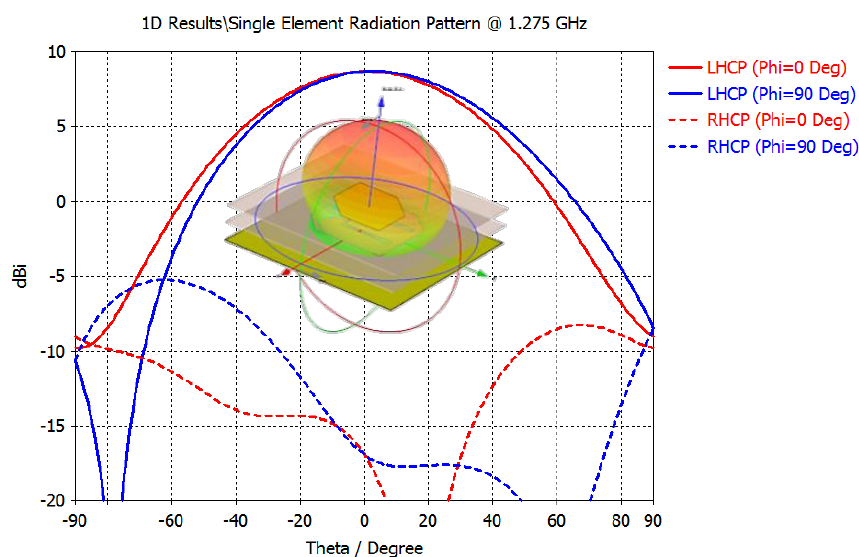
Figure 4. Radiating element simulated axial ratio expressed in dB.